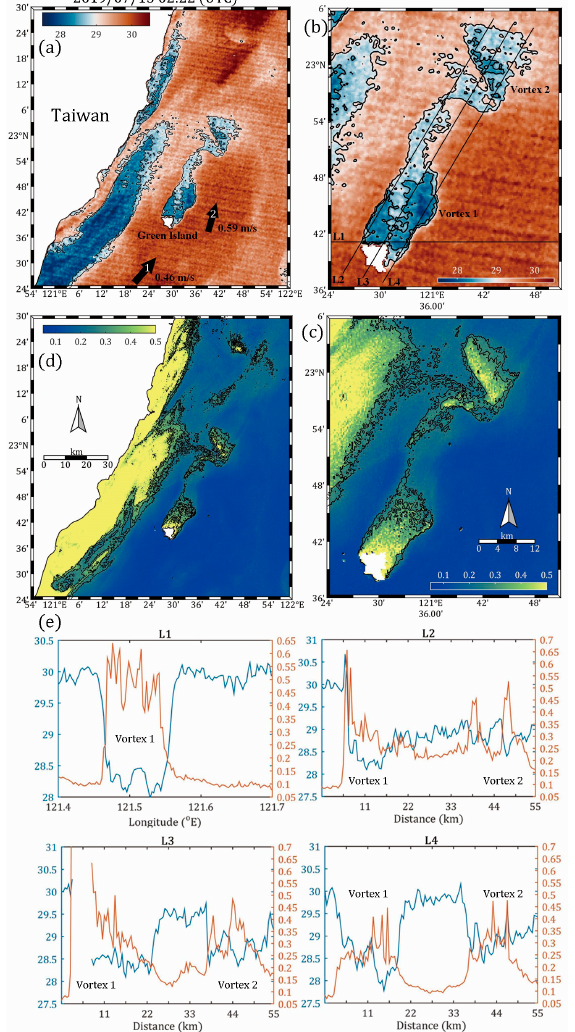
Figure 5. Case of the island vortex obtained from GCOM-C SGLI image taken at 02:22 (UTC), July 13, 2019. ( a , b ) SST ( ◦ C), ( c , d ) Chl-a (mg/m 3 ), ( e ) SST, and Chl-a values of L1 to L4 in (b). The black arrow in ( a ) is the current velocity from the OSCAR data. The first arrow (22.33 ◦ N, 121.33 ◦ E) has a speed of 0.46 m / s, and the second arrow (22.67 ◦ N, 121.67 ◦ E) has a speed of 0.59 m /